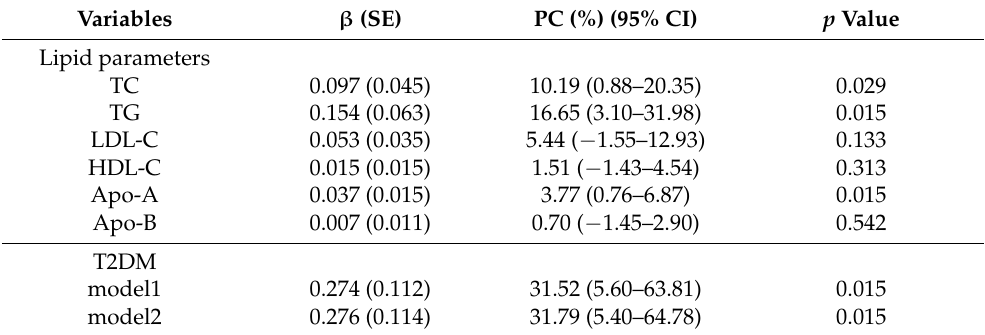
Table 2. The association of ABCB1 rs4148727 with baseline incident T2DM and lipid parameters.